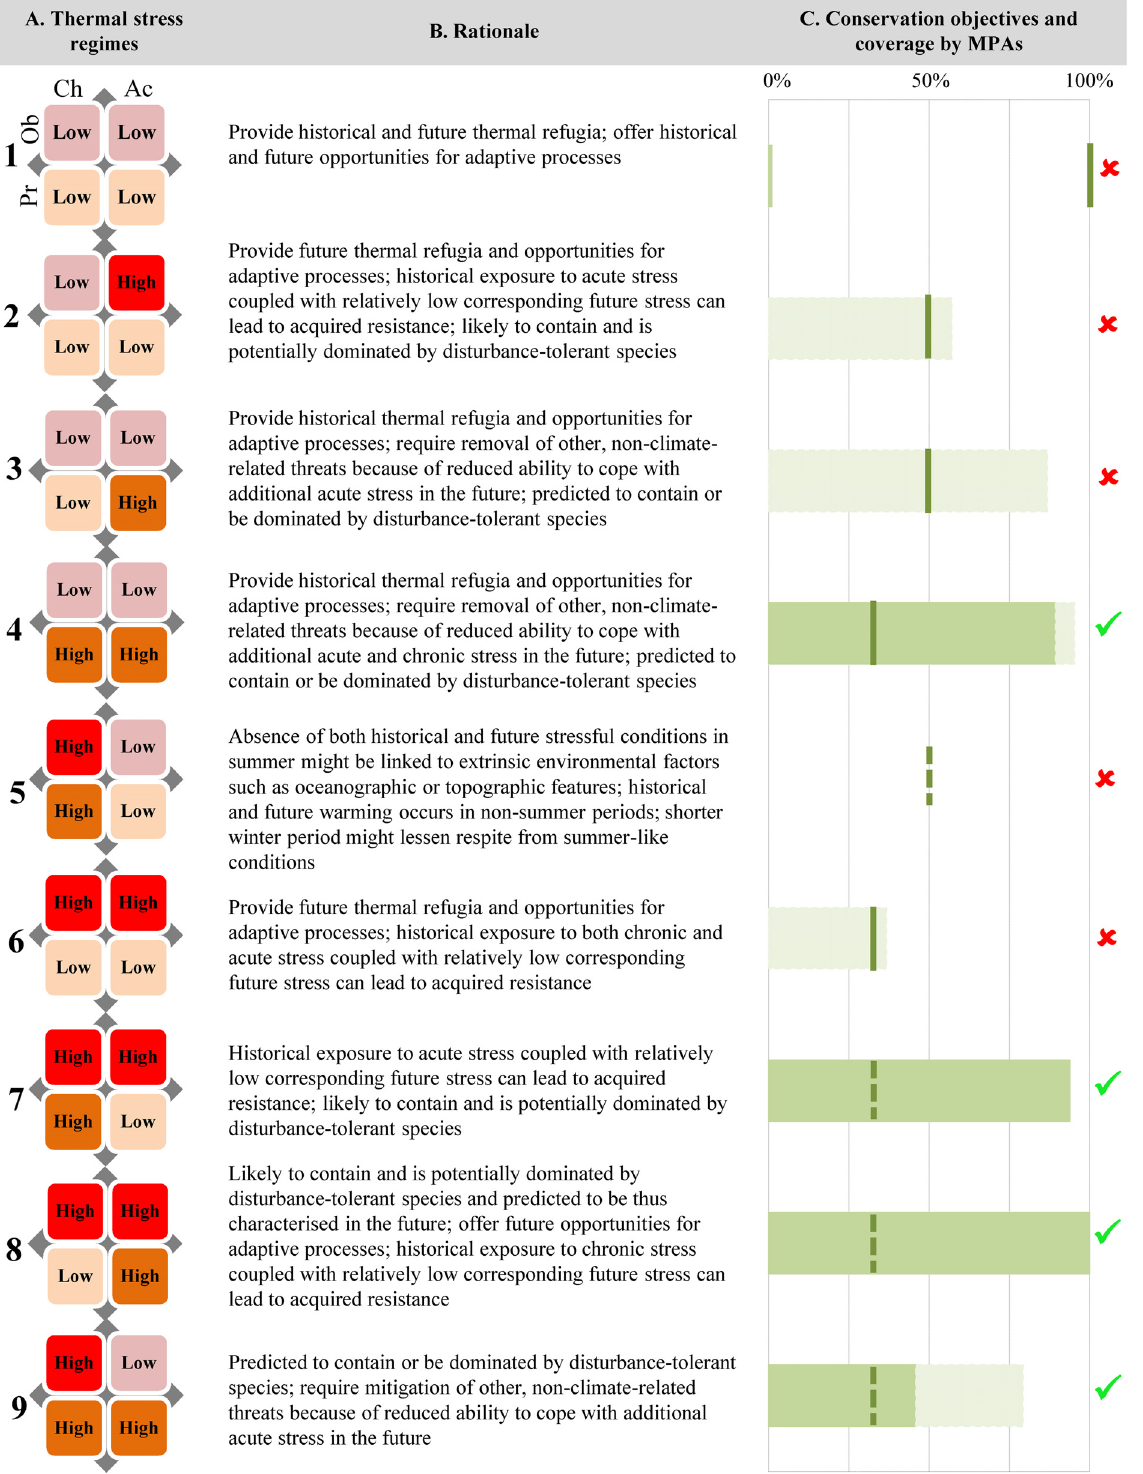
PLOS ONE | DOI:10.1371/journal.pone.0140828 November 4,